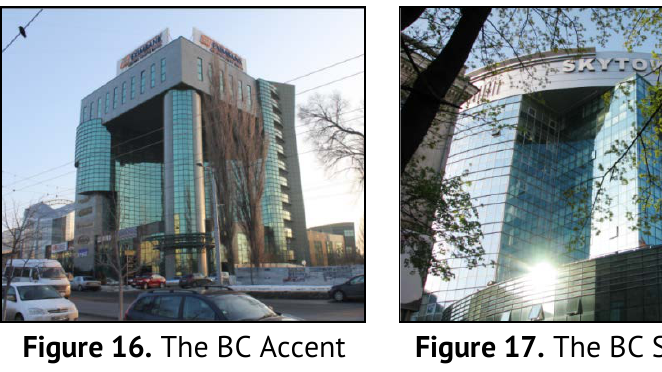
Figure 18. The BC Le Roi, 2008.